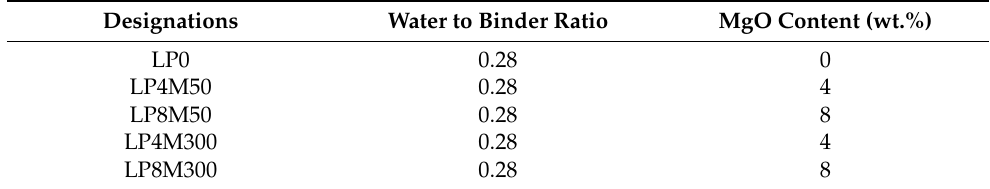
Table 2. Mixture proportion of paste